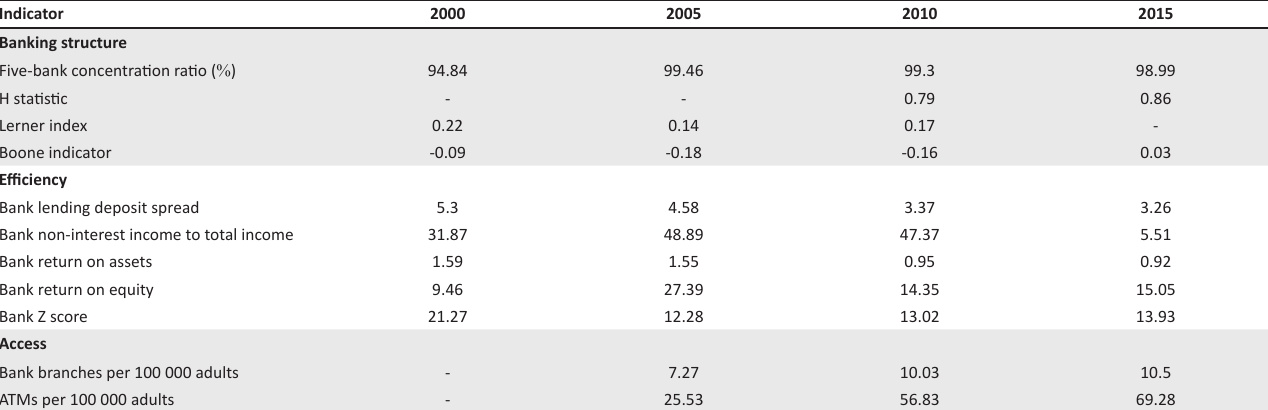
TABLE 1: Main banking indicators.